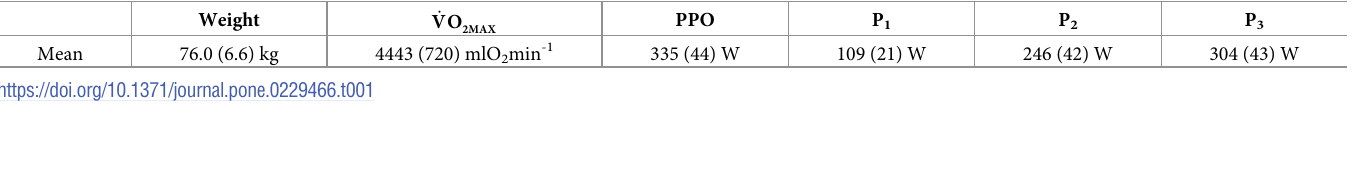
Table 1. Participants’ characteristics: Mean (SD) of the weight, the maximal oxygen uptake ( _ VO ), the peak power output (PPO) and the three intensity-levels 2MAX adopted in the second and third tests (P 1 , P 2 and P 3 ). Weight _ VO 2MAX